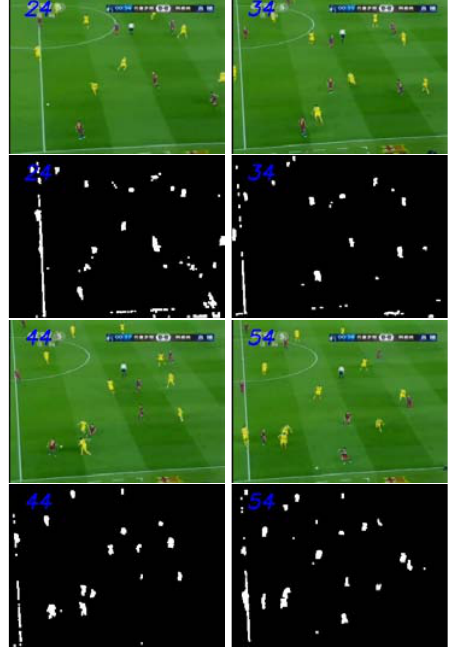
Fig. 3. Locations of objects detected by GMM.